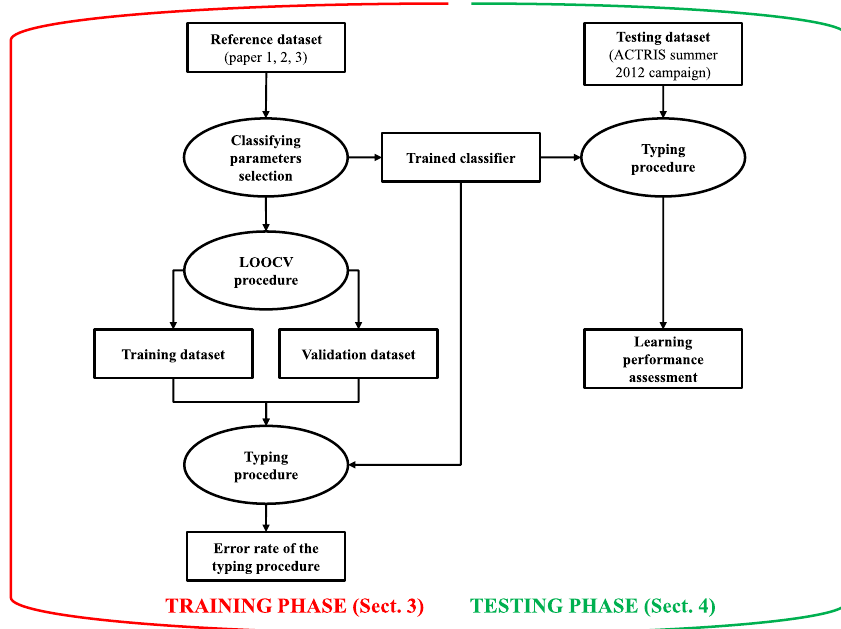
Figure 4. Flowchart of the methodology. First, well characterized aerosol layers are grouped into meaningful classes that represent the reference dataset: paper 1 (Papagiannopoulos et al., 2016a), paper 2 (Pappalardo et al., 2013), and paper 3 (Schwarz, 2016). Second, an analysis is performed to determine the best performing classifying parameters among the available intensive parameters. Third, based on the reference dataset the selected classifier is validated using the leave-one-out cross validation (LOOCV) procedure in order to ensure correct aerosol type separation. Finally, the trained typing algorithm is applied to an independent and manually typed dataset (the testing dataset) for the assessment of the algorithm performance. Note that both phases have been applied with and without the depolarization ratio.